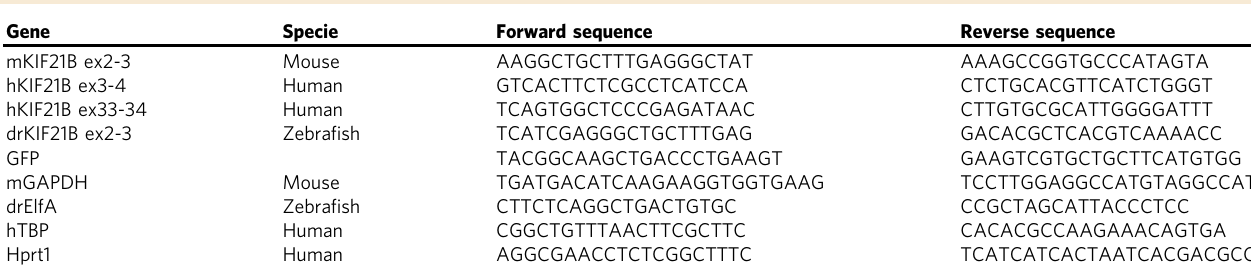
Table 2 List of primers used for